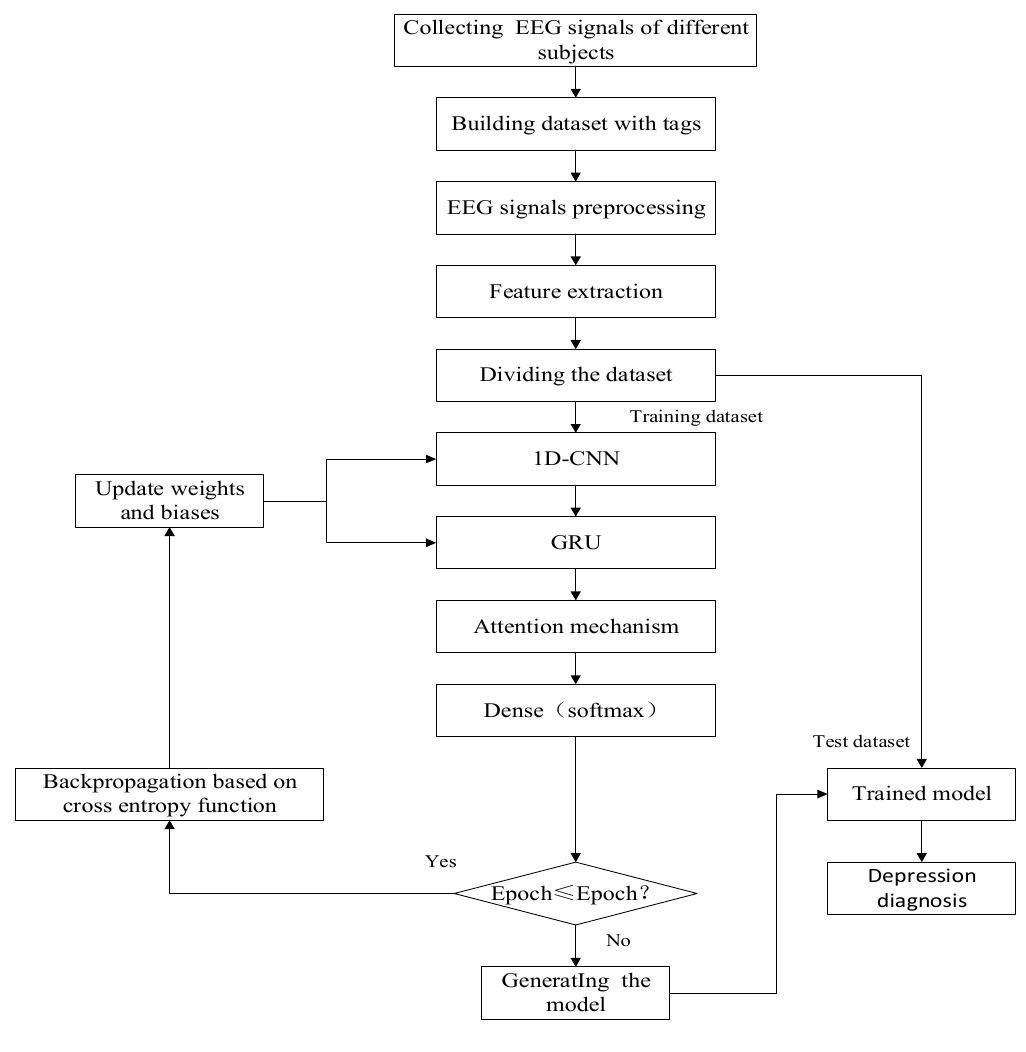
Figure 6. Depression diagnosis algorithm